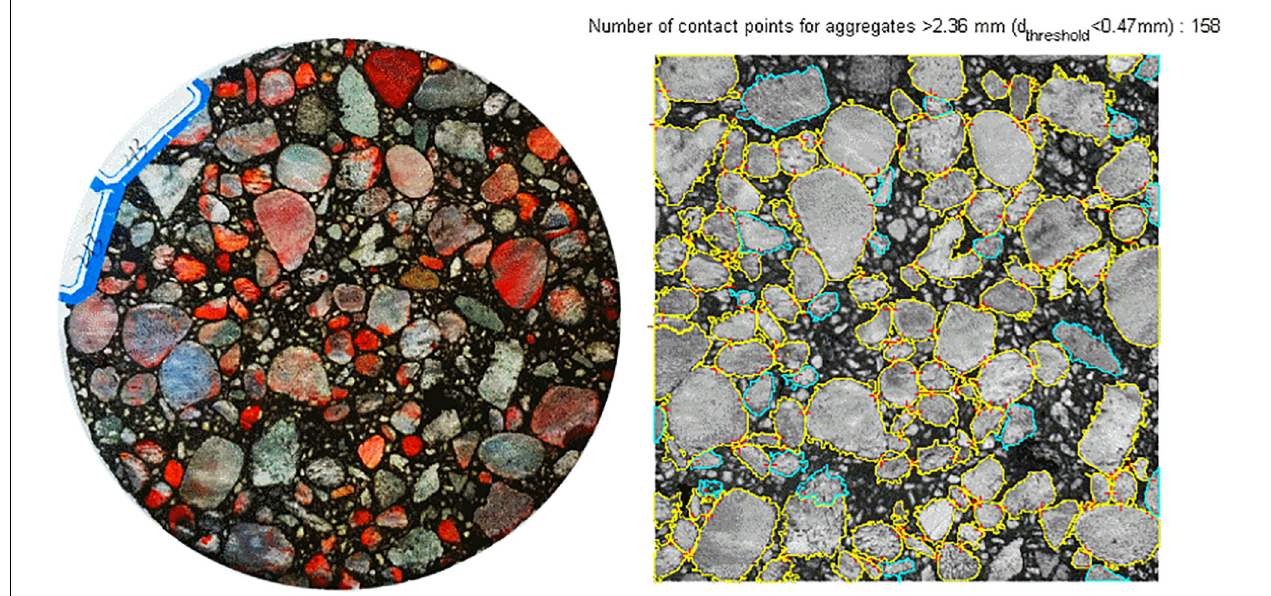
FIGURE 4 | Analysis, classification, and counting of contact